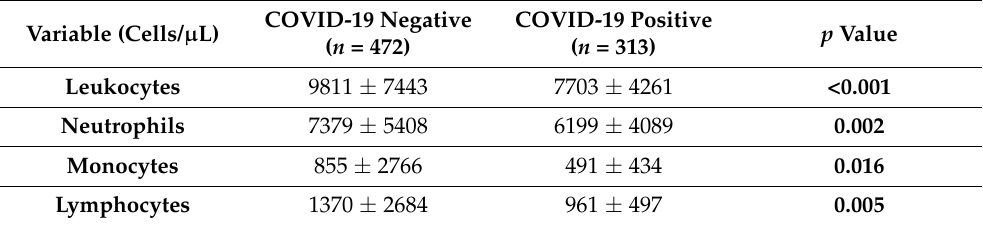
Table 4. Comparison of leukocytes levels (neutrophils, lymphocytes and monocytes) by Student’s t -test between patients who were positive and negative in COVID-19, showing lower levels of white cells in patients with COVID-19. Patients negative in COVID-19 were considered patients included in groups flu positive and pan-viral negative) Values are expressed as mean ± SD.